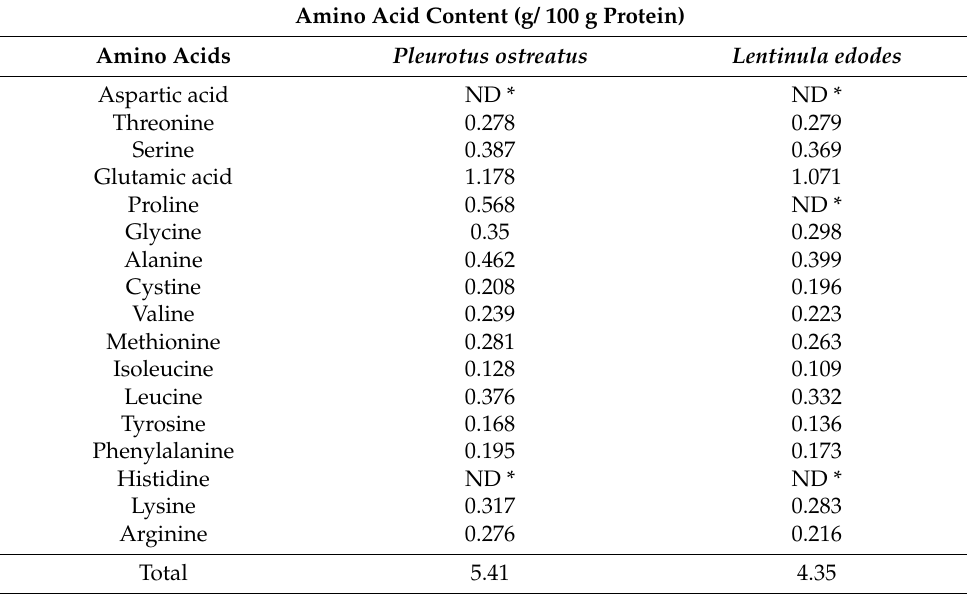
Table 4. Amino acid composition of Pleurotus ostreatus and Lentinula edodes extracts.